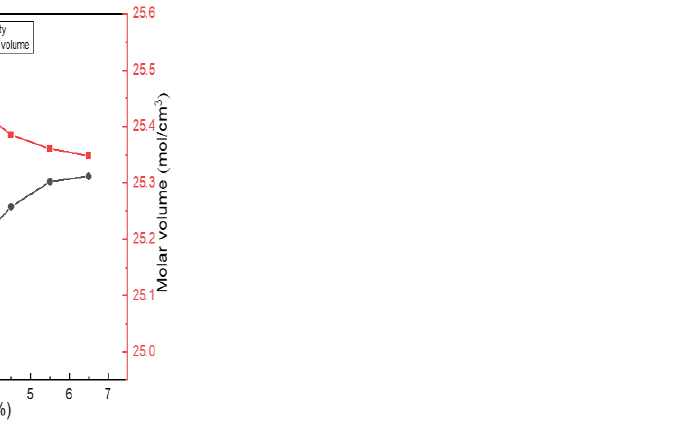
Figure 7. Change curves of physical properties of Li 2 O − Al 2 O 3 − SiO 2 series glass with different B 2 O 3